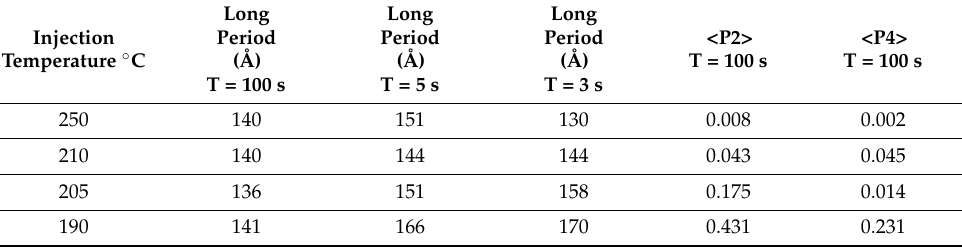
Table 2. The Long Period evaluated from SAXS patterns for each injection temperature at times 100 s, 5 s, and 3 s after crystallization commenced and the global orientational parameter <P 2 > and <P 4 > of the lamellar crystals evaluated from SAXS patterns for each injection temperature at a time 100 s after crystallization commenced. The temperature of the mould was fixed at 50 ◦